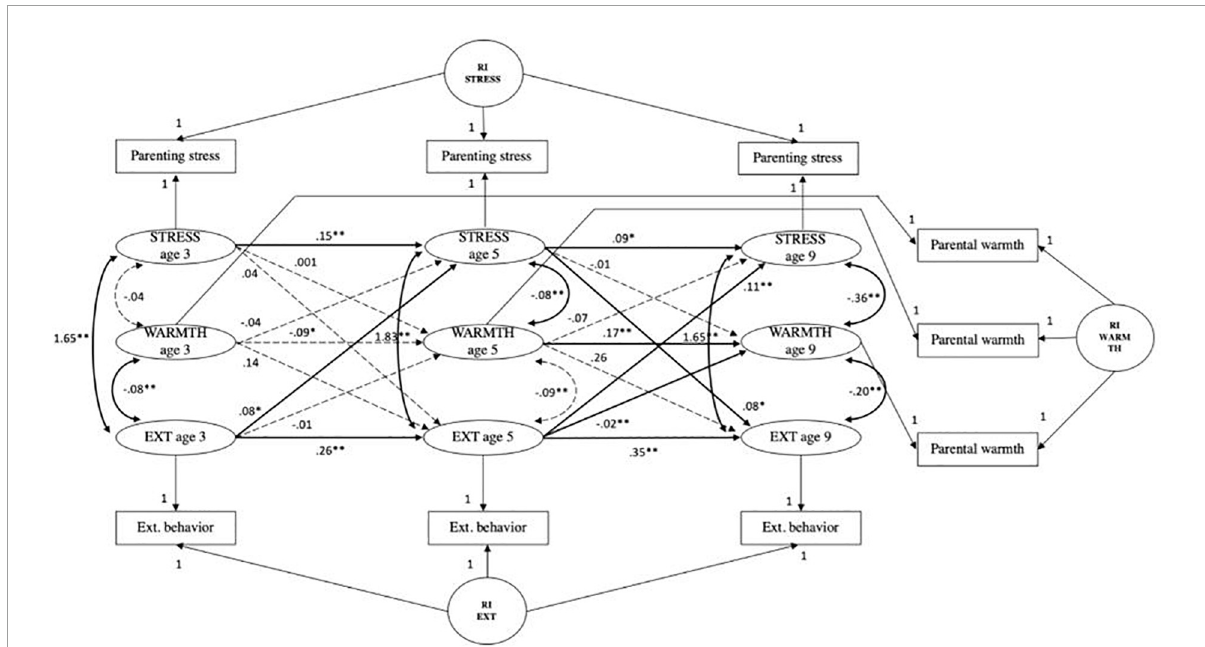
FIGURE5 Random intercepts cross-lagged panel model showing relations among parenting stress (STRESS), parental warmth (WARMTH) and child externalizing behaviors (EXT) across three waves. Age 3, wave 2; age 5, wave 3; age 9, wave 5; R, residual variance; RI EXT, random intercept child externalizing behavior; RI STRESS, random intercept parenting stress; RI WARMTH, random intercept parental warmth. Standardized estimates reported. Gray dashed paths indicated non-significant estimates. ∗ p < 0.01, ∗∗ p < 0.001.